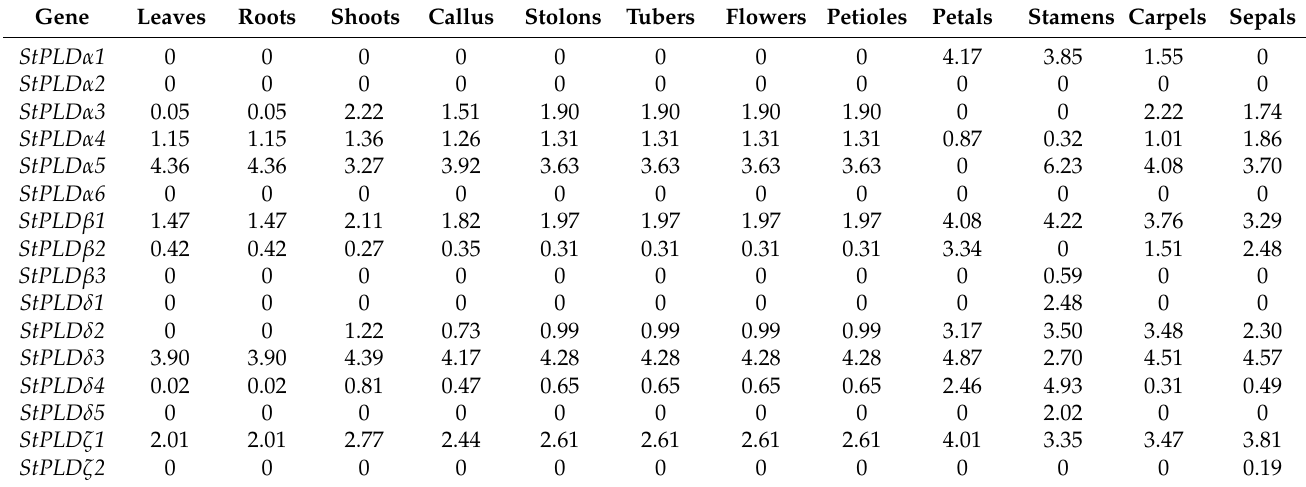
Table A3. FPKM values of auxin transporter genes in various tissues.